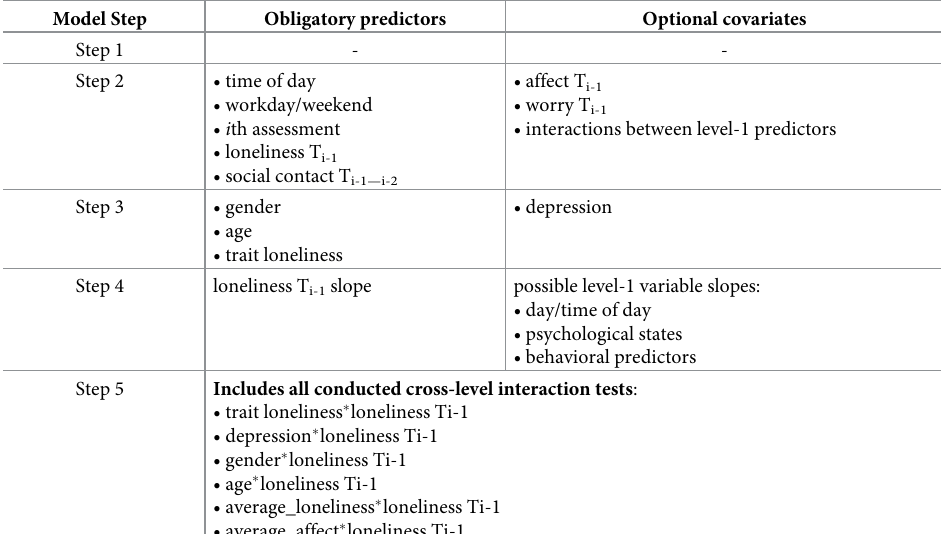
Table 2. Display of obligatory and optional variables included at the respective steps of model